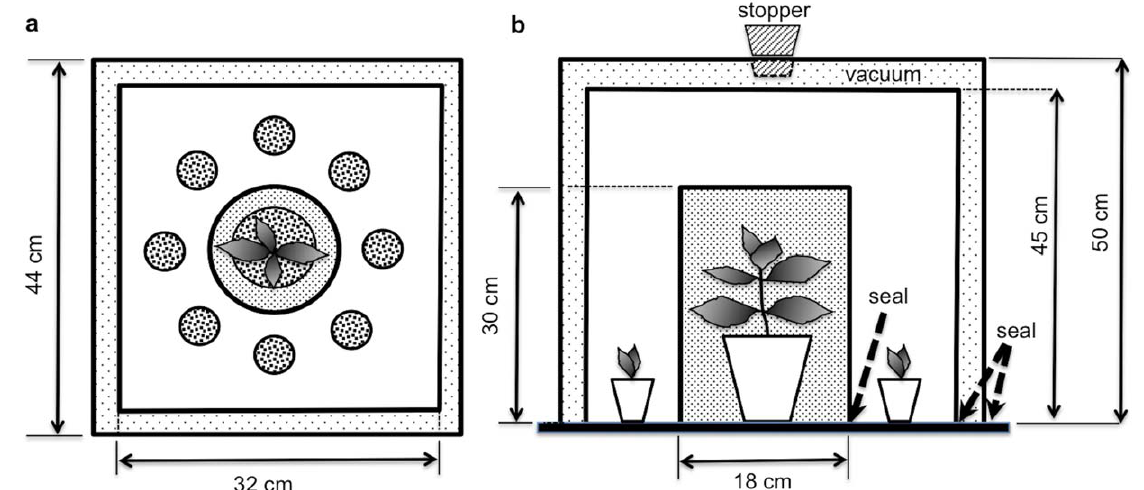
Figure 1. Schematic representation of the custom-designed experimental unit (not in scale). ( a ) The seal at the base of the central cylindrical box ensured that chilli seeds arranged in a circle around the adult plant were chemically isolated from it. ( b ) All seeds and adult plants within a replicate unit were housed within 2 different sized square boxes, one inside the other, with the air in between the two boxes removed using a vacuum pump. The whole experimental unit was custom-made in colourless cast acrylic material (ModenGlas), which transmitted 92% of visible light, but was opaque to ultraviolet and infrared wavelengths.